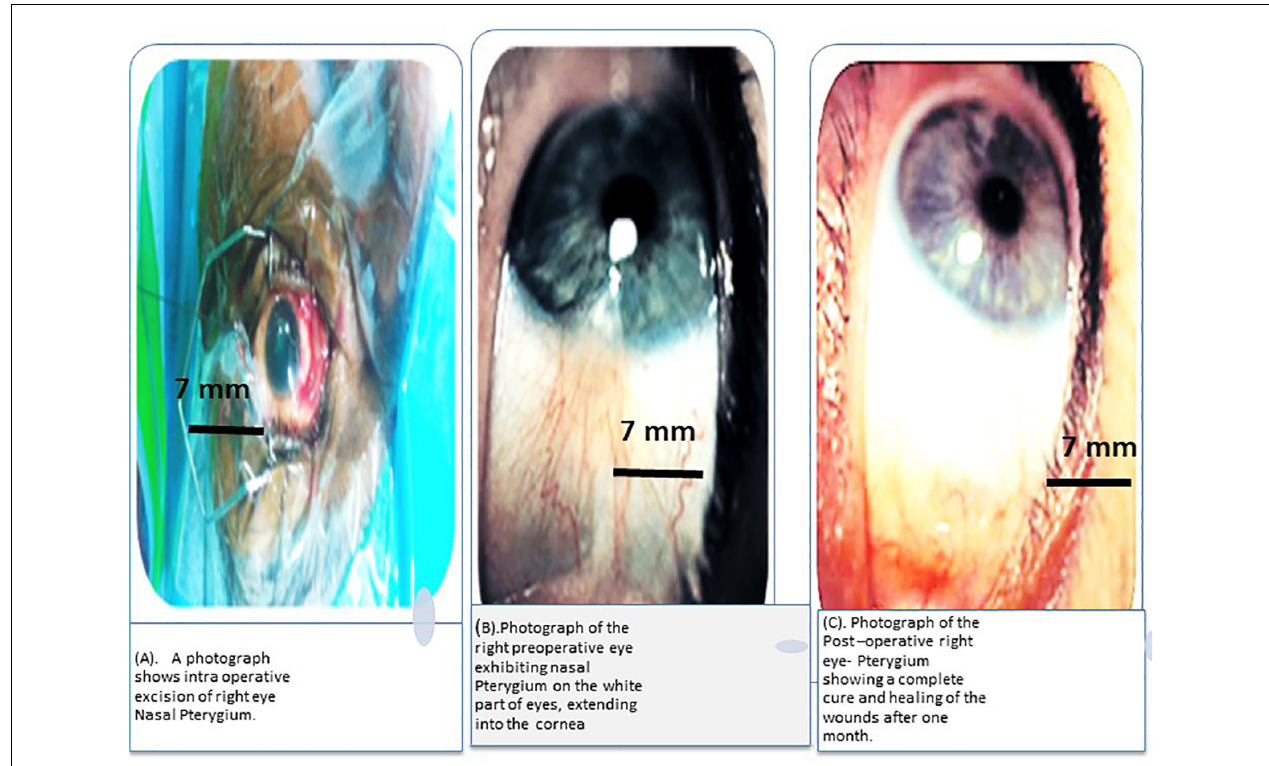
FIGURE 5 | (A) A photograph depicts the removal of a Nasal Pterygium from the right eye during surgery. (B) Preoperative photograph of the right eye showing nasal Pterygium, a mucous membrane that protects the white portion of the eye and extends into the cornea. (C) After 1 month, the post-operative right eye-pterygium has fully healed and the wounds have healed completely.